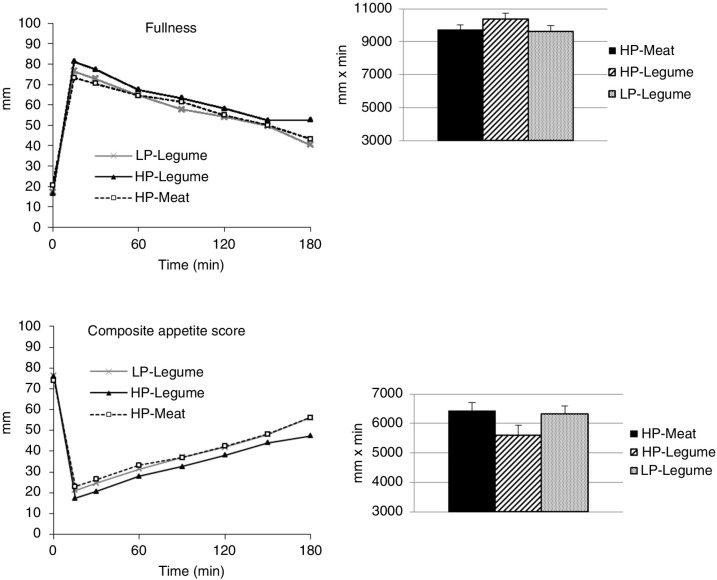
Left panel: Line chart of unadjusted mean ratings. Right panel: Bar chart of mean (±SEM) area under the curves (AUC) for fullness and composite appetite score during 3 h after 3 iso-caloric test meals (n=43). Fullness: Repeated measures (with and without adjustment for palatability): Meal p<0.05, Time p<0.0001. Fullness higher after HP-Legume compared with HP-Meat and LP-Legume (p<0.05). AUC: HP-Legumes>LP–Legumes (p<0.05). No differences in AUC after adjusting for palatability. Composite appetite score (CAS): Repeated measures (with and without adjustment for palatability): Meal p<0.05, Time p<0.0001. HP-Legume lower CAS than HP-Meat and LP-Legume, p<0.05. After adjustment for palatability: HP-Legume lower than HP-Meat, p<0.05 (but not than LP-Legume). AUC: HP-Legumes lower than LP-Legumes, p<0.05. No differences in AUC after adjustment for palatability. HP-Meat: high protein (19 E%) from veal and pork meat. HP-Legume: high protein (19 E%) from legumes. LP-Legume: low protein (9 E%) from legumes.